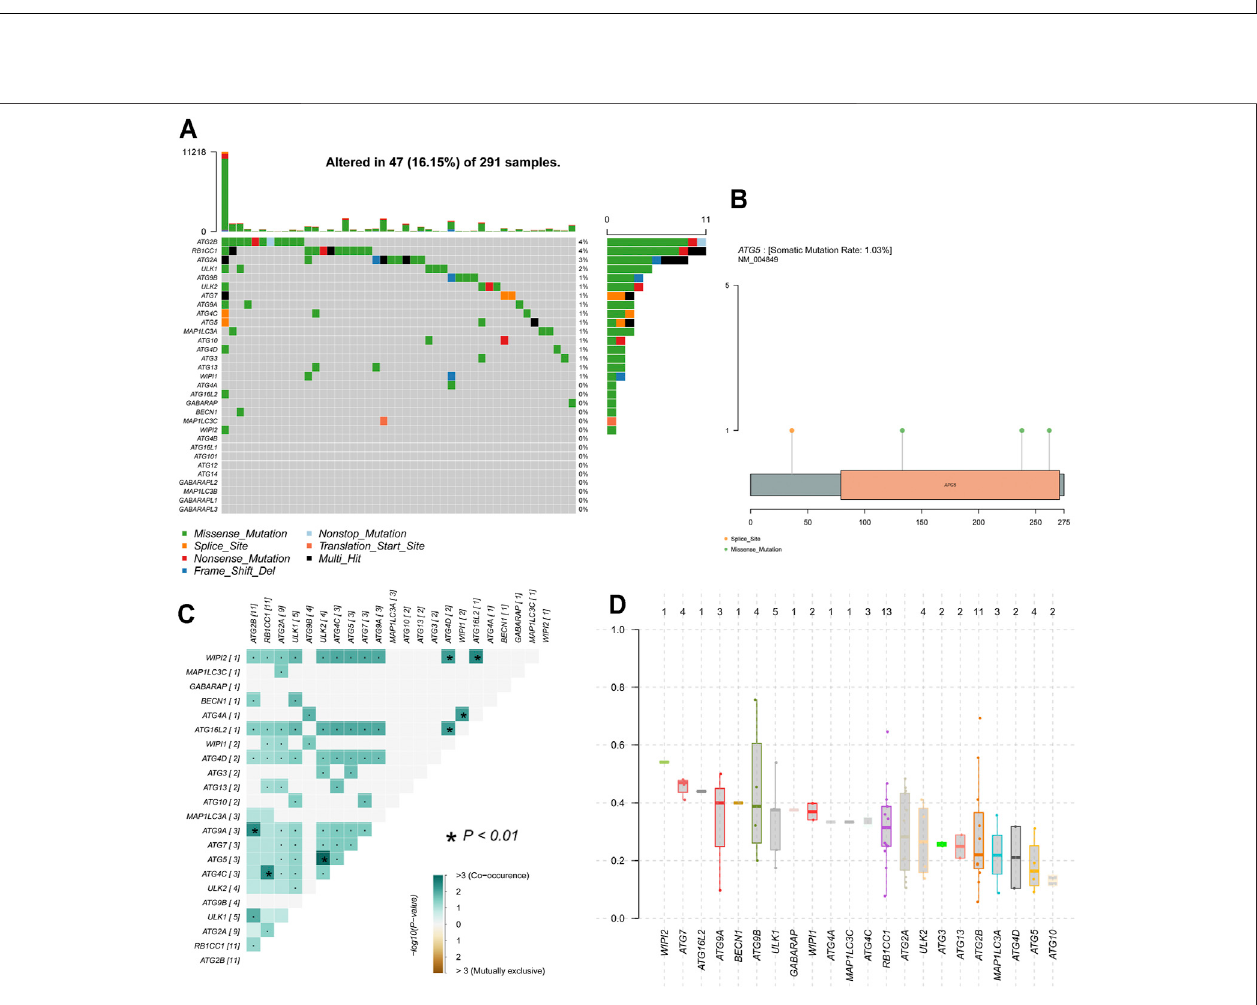
FIGURE6 | Mutation data analysis ofARGs inCESC (A) Waterfallplotsof ARGsmutationresults show thatATG2B and RB1CC1 arethe most frequently mutated genes.Atotalof16geneshasamutationrate ≥ 1% (B) mutationtypeanddomainofATG5 (C) Theco-occurrenceofARGsmutationincervicalcancer.Dotrepresentsas no statistical signi fi cance, * p < 0.01. Green means co-occurrence (D) The variant allele frequency (VAF) distribution of ARGs in CESC by plotvaf function in “ maftools ” package. Each dot in the boxplot represents a variant. The total number of variants is list on the top of each box.